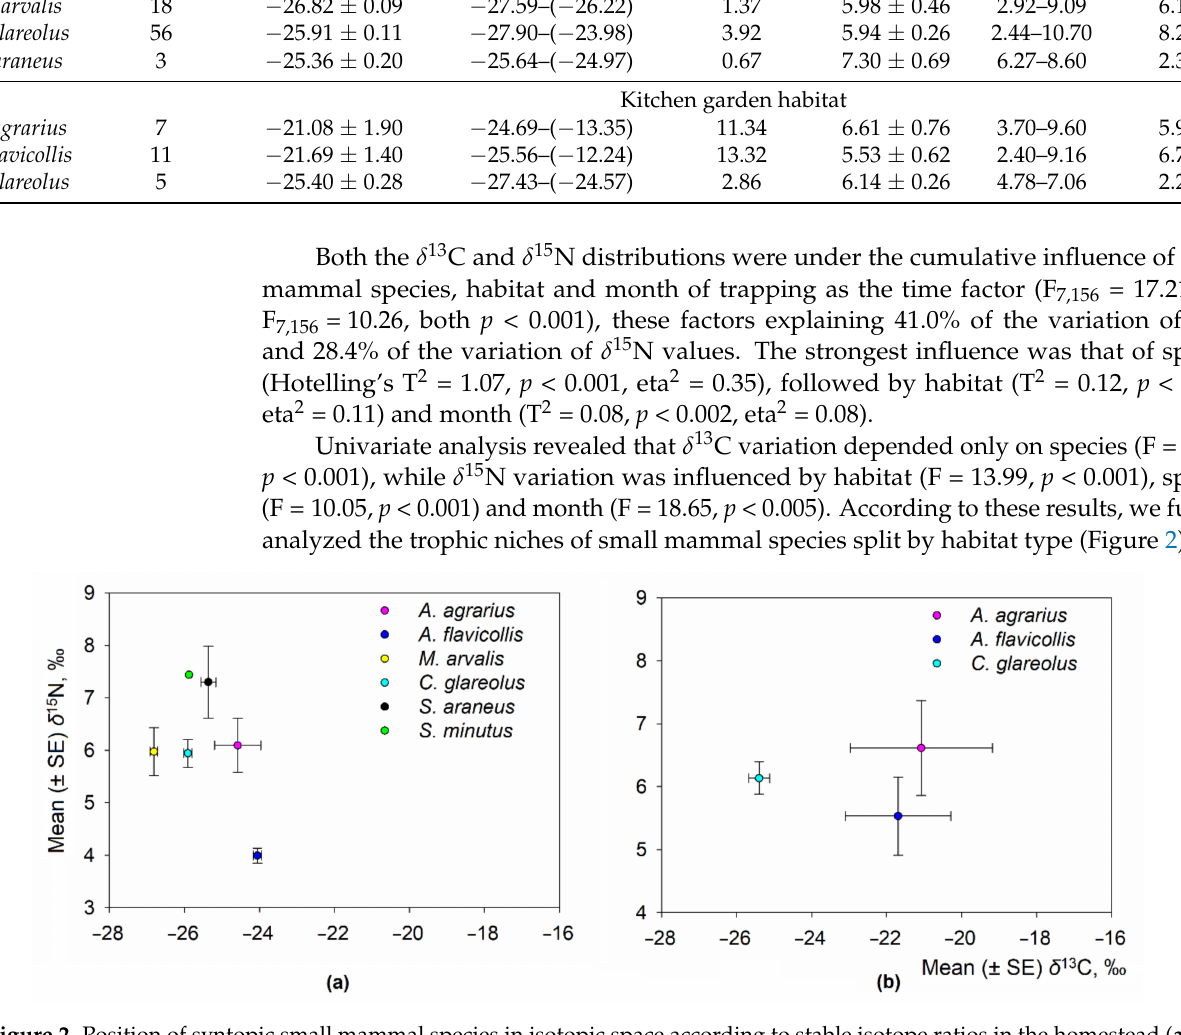
Figure 2. Position of syntopic small mammal species in isotopic space according to stable isotope ratios in the homestead ( a ) and kitchen garden ( b